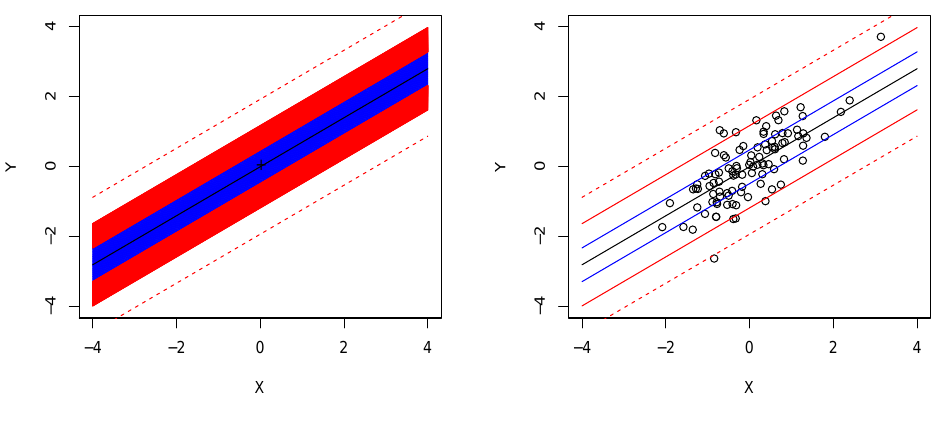
Figure 3: BBP in option 3.1 (left) for the normal model considered in Example 2.1. The blue region contains the 50% of the data and the two red regions the 40% . The dashed lines represent the BBP in option 3.2 . In the right plot we add 100 simulated data from this